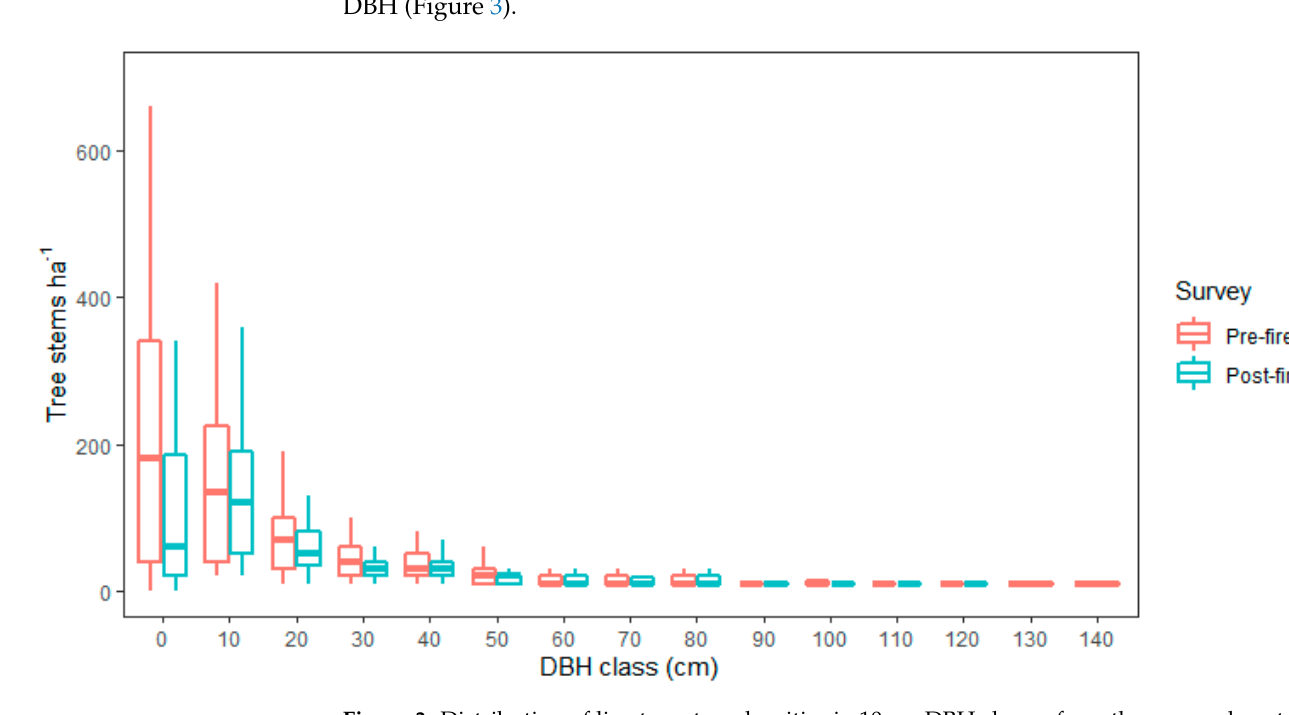
Figure 3. Distribution of live tree stem densities in 10 cm DBH classes from the pre- and post-fire surveys. Each box and whisker represents the variation in live tree stem abundance across all 59 plots for the given survey and stem class. Distributions are represented by the median (centre line of the box), the 25th and 75th percentile (lower and upper limits of the box respectively) and the 2.